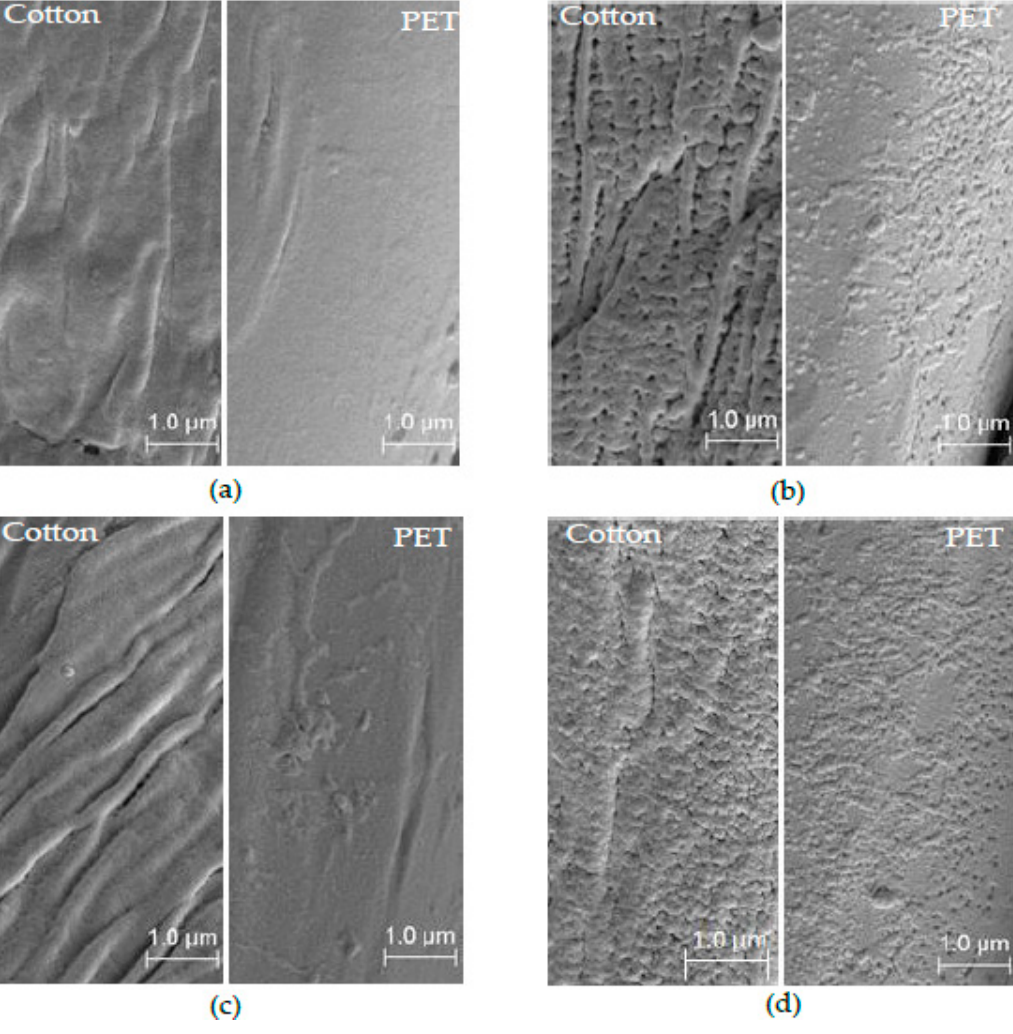
Figure 11. SEM images: ( a ) untreated; ( b ) air; ( c ) Ar and ( d ) O 2 plasma treated P/C blend fabric at LPP conditions (60 sccm, 500 W, 0.3 mbar and 10 min).